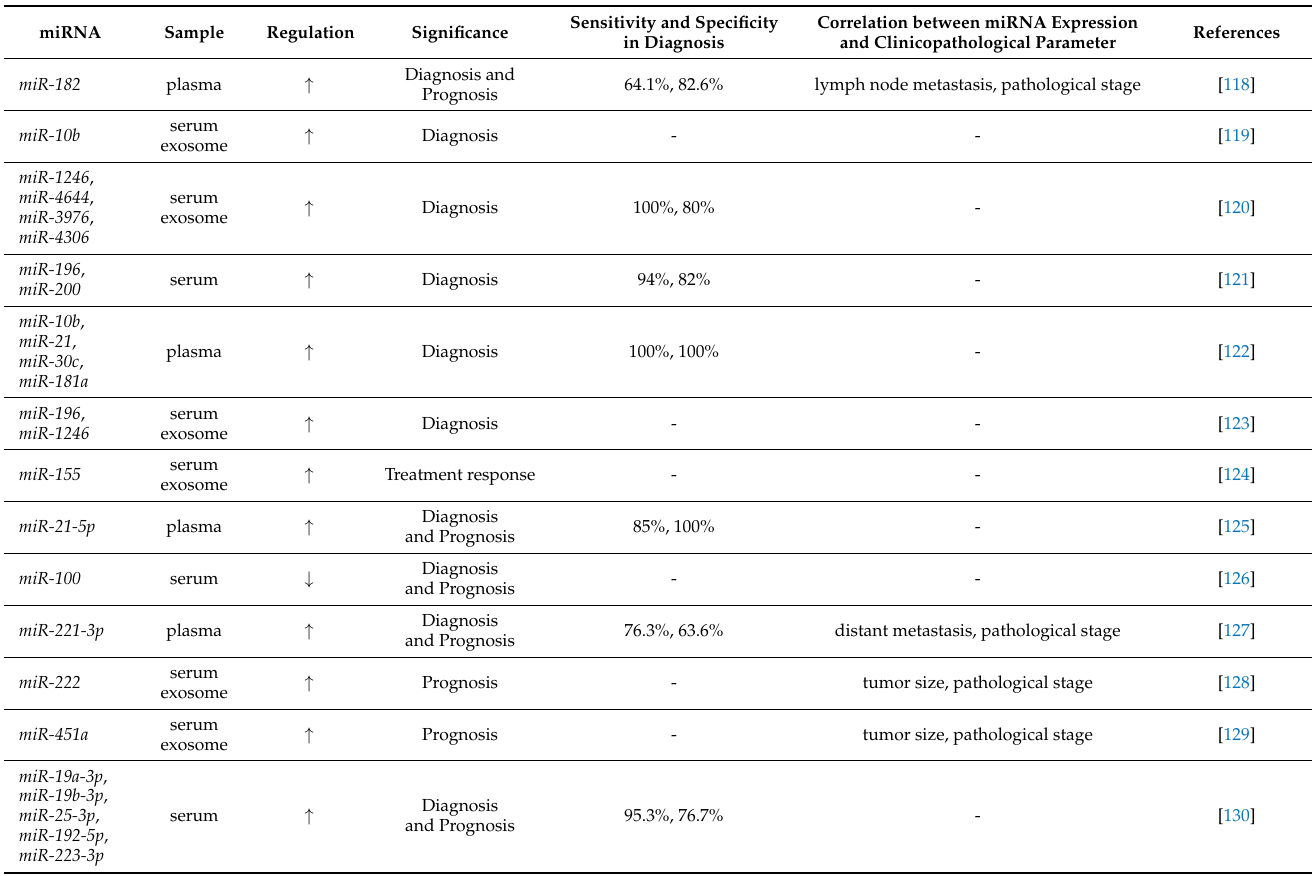
Table 5. Pancreatic